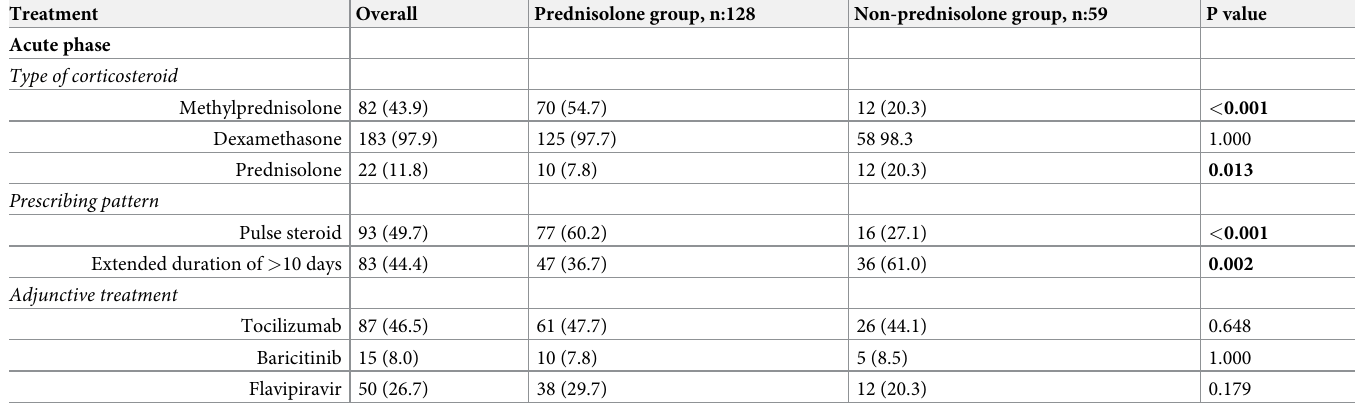
Table 2. Systemic corticosteroid and adjunctive therapy during acute phase of COVID-19 infection.